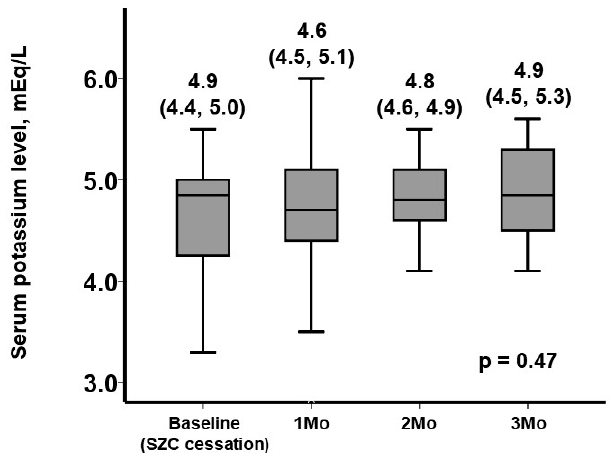
Figure 1. Three-month trends of serum potassium levels following SZC cessation.